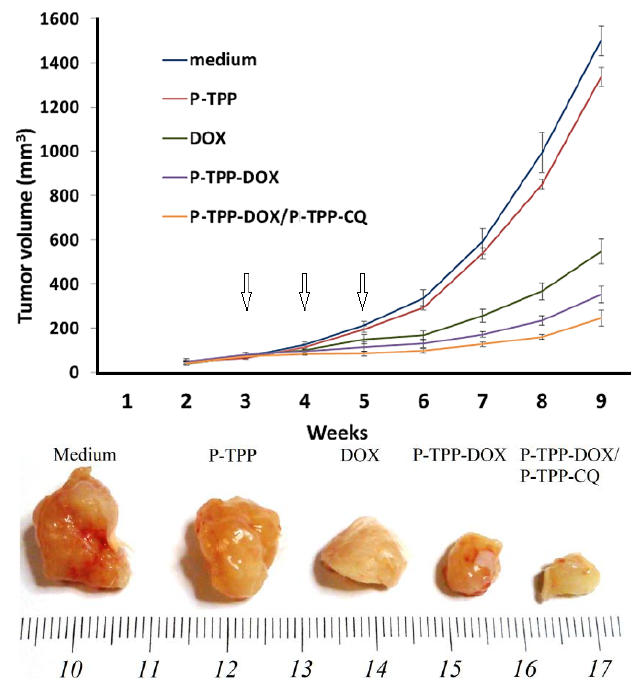
Figure 4. CQ and DOX encapsulation in P-TPP reduces DU145 tumor growth in SCID mice in comparison to treatment with free or nanocarrier-encapsulated DOX. ( Upper part ): Growth rates of tumor xenografts in SCID mice. Formulations were administered intraperitoneally on Weeks 3, 4 and 5 (arrows). Group 1 mice were treated with medium (Opti-MEM); Group 2 with nanocarrier P-TPP (75 mg/kg); Group 3 with DOX (2 mg DOX/kg); Group 4 with P-TPP-DOX (0.75 mg/kg); Group 5 with P-TPP-DOX (0.75 mg/kg)/P-TPP-CQ (4.5 mg/kg). ( Lower part ): Representative images of tumors excised after nine weeks (experimental endpoints).